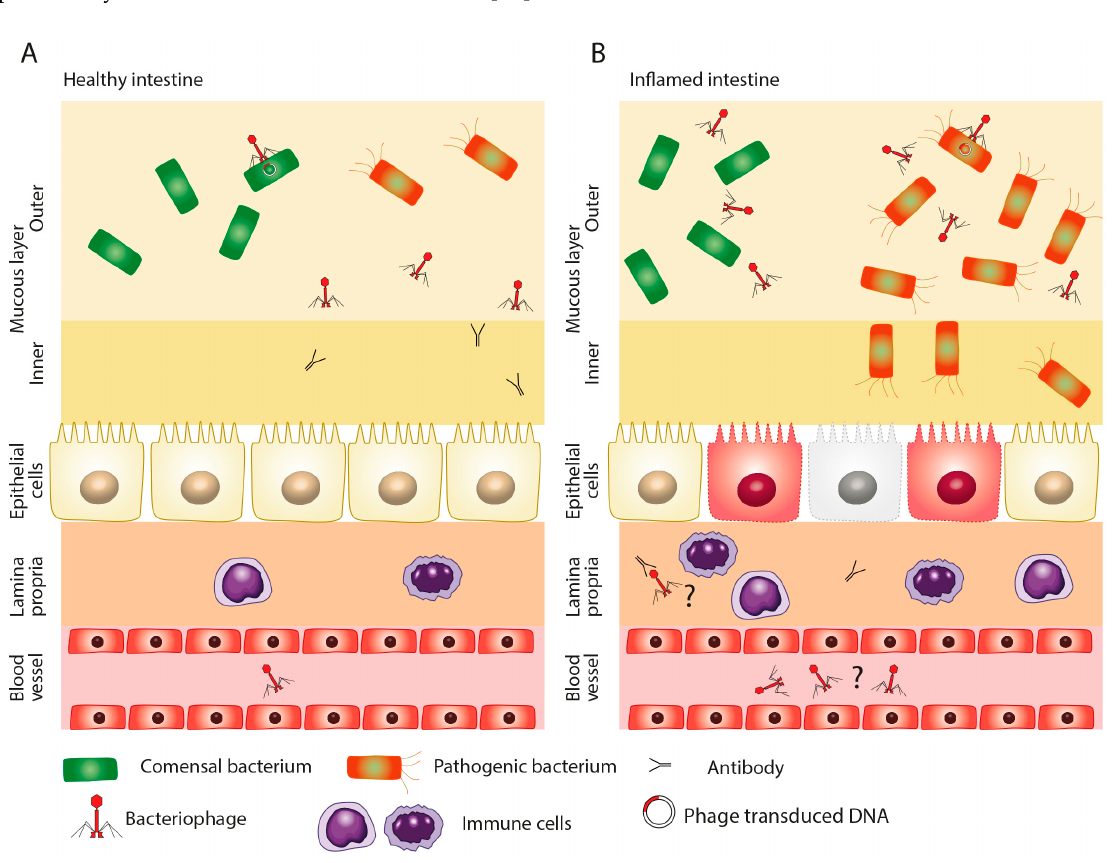
Figure 3. Presence of phages in circulation. Phages may be present in the circulation in a healthy individual ( A ) as well as during the course of intestinal inflammation ( B ). The higher abundance of phages in the circulation during intestinal inflammation may be due to increased intestinal permeability and the erosion of the mucosal wall.